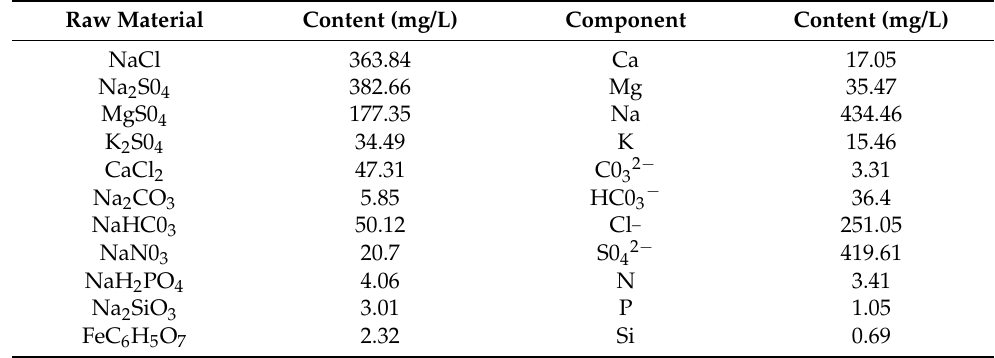
Table 1. F/2 medium